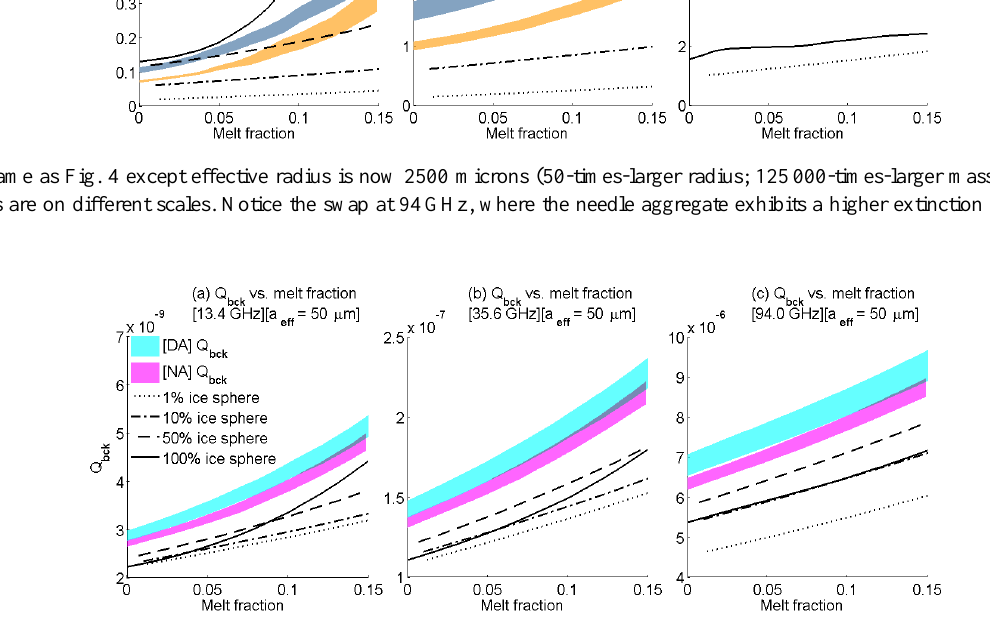
Figure 6. Similar to Fig. 4, the single-particle backscattering efficiency coefficient ( Q bck ) is shown for 50-micron effective radius. Both ag- gregates show consistently larger backscattering efficiencies for the same mass as melt fractions compared to the spheres. Note the difference in the vertical axes on each